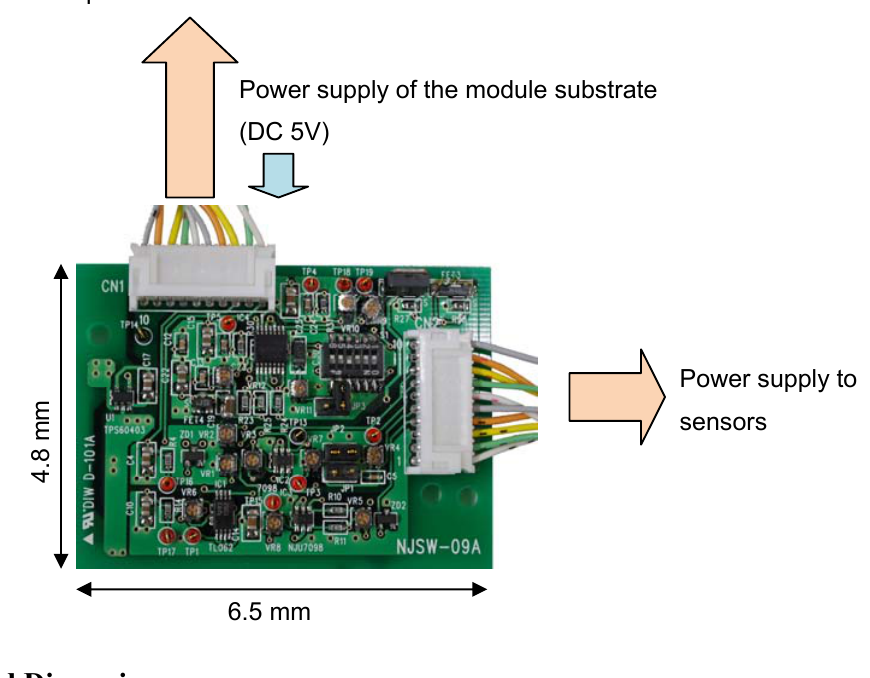
Figure 5. Photograph of signal processing